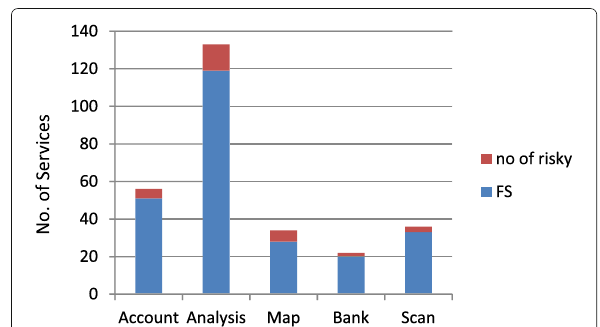
Fig. 3 Number of risky services per domain